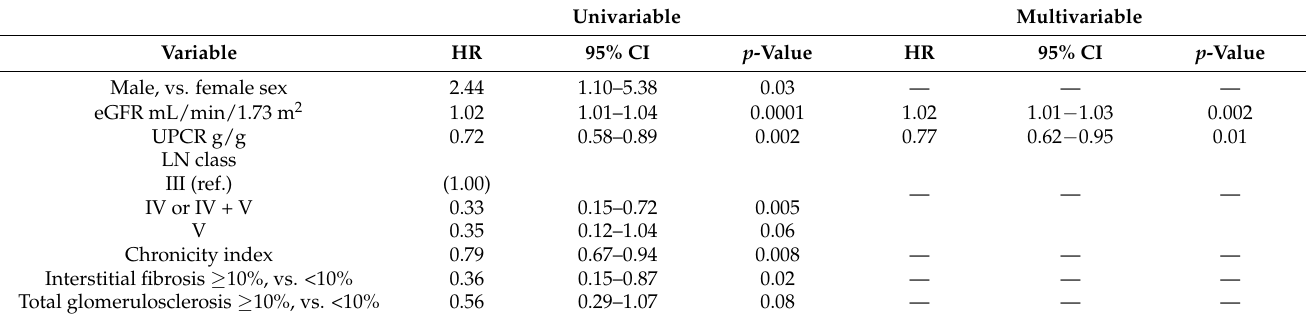
Table 2. Results of uni- and multivariable Cox proportional hazard regression models for predicting complete renal response within 36